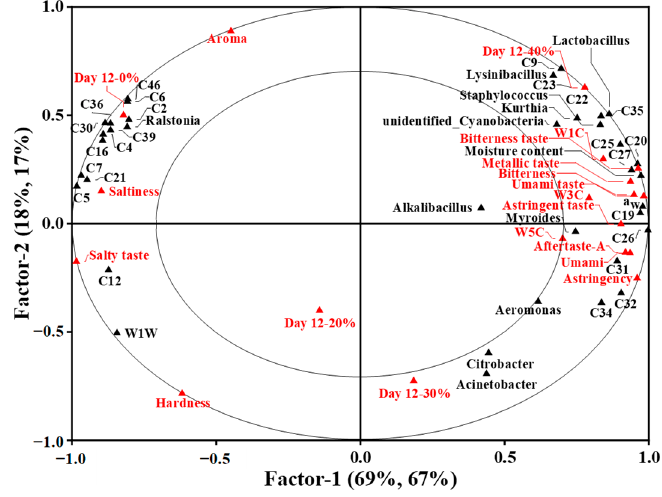
Figure 5. The correlation loading plot for the sausages at day 12 based on partial least squares regression for X-matrix (including physical properties and bacterial counts with significant difference among treatments ( p < 0.05), dominant bacteria and key volatile compounds) and Y-matrix (including E-nose sensor responses and E-tongue sensor responses with significant difference among treatments ( p < 0.05), sensory attributes and treatments). 0%: control dry sausage (2.50% NaCl); 20%: dry sausage with 20% KCl substituted for NaCl (2.00% NaCl + 0.50% KCl); 30%: dry sausage with 30% KCl substitution (1.75% NaCl + 0.75% KCl); 40%: dry sausage with 40% KCl substitution (1.50% NaCl + 1.00%